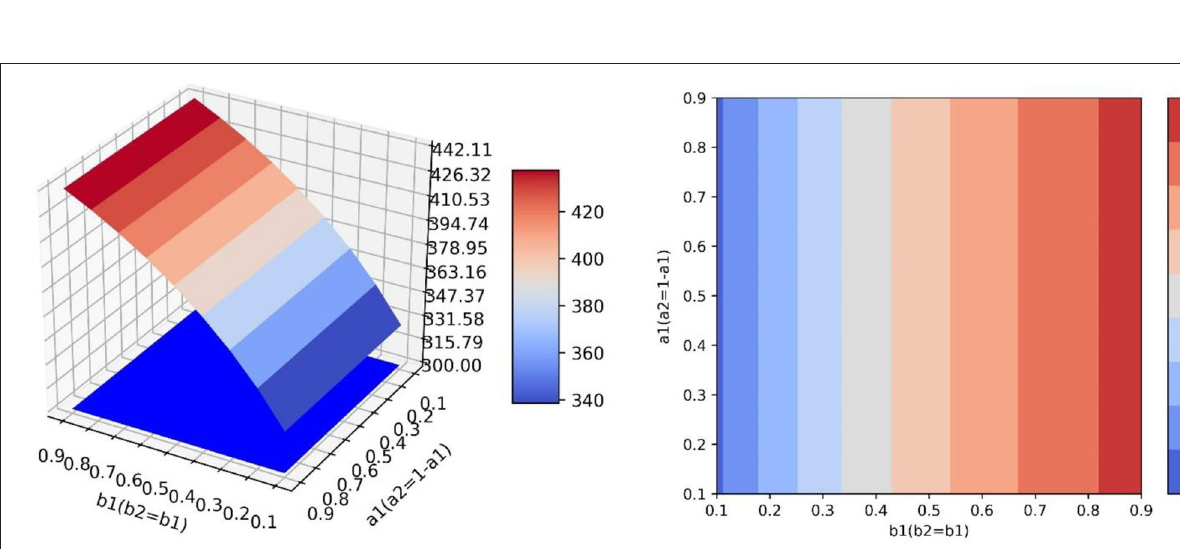
Frontiers in Psychology | www.frontiersin.org 11 May 2022 | Volume 13 | Article